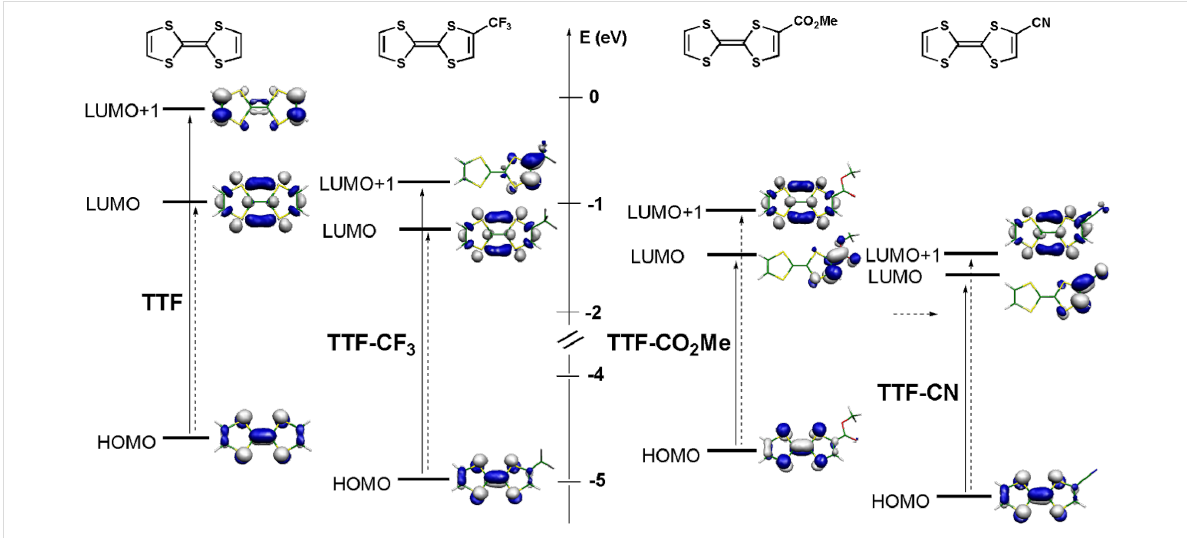
Figure 2: Calculated frontier orbitals of geometry-optimized [B3LYP/6-31G(d)] model compounds TTF, TTF-CF 3 , TTF-CO 2 Me and TTF-CN, with the lowest energy optical transitions deduced from TD-DFT calculations (see Table 3).